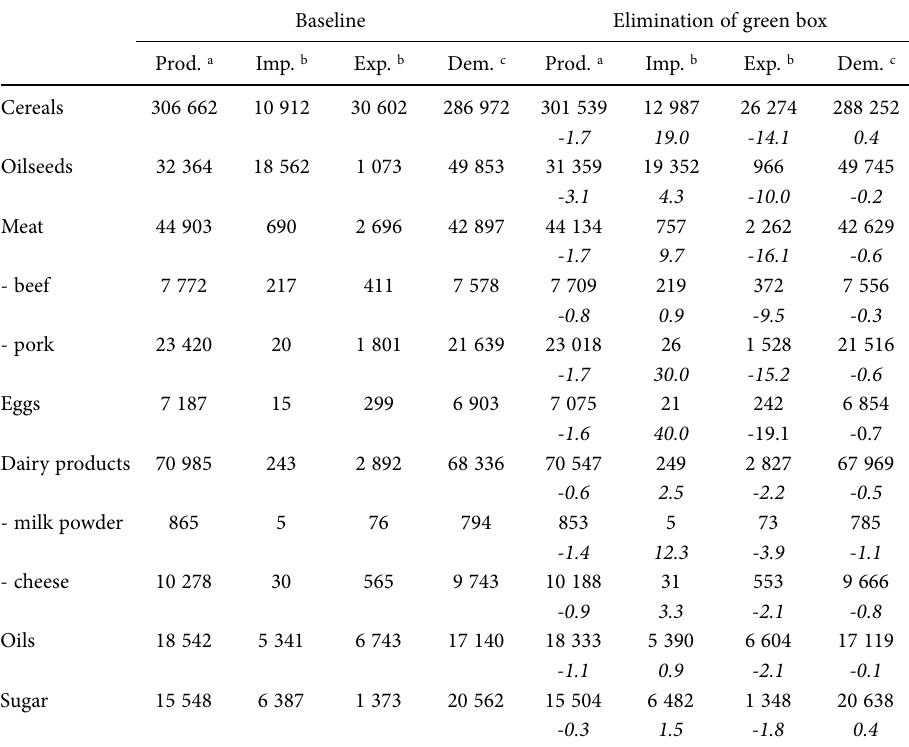
Table 2. Market balance for the EU in 2020 by type of scenario (1000 tons, percentage change com- pared to baseline in